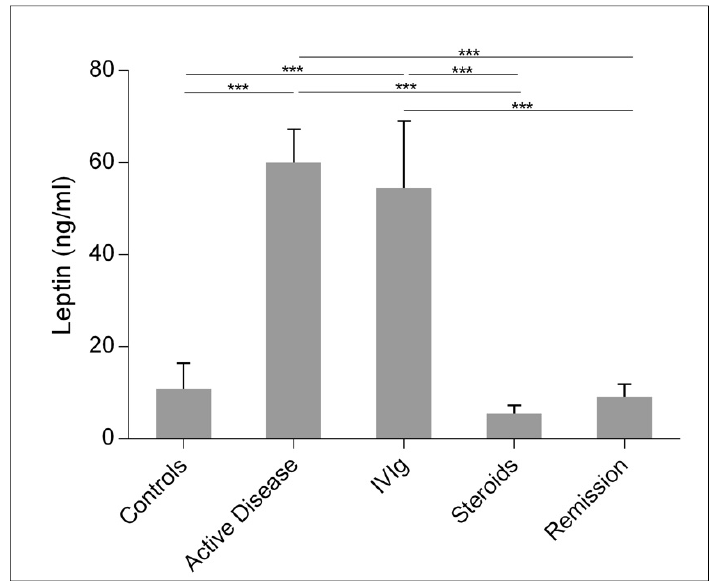
Figure 1. Plasma leptin levels in controls and children with ITP in the acute phase, after treatment with IVIg and/or steroids, and in remission. Leptin levels are shown as mean (SD). Asterisks indicate statistical significance (*** p < 0.001).